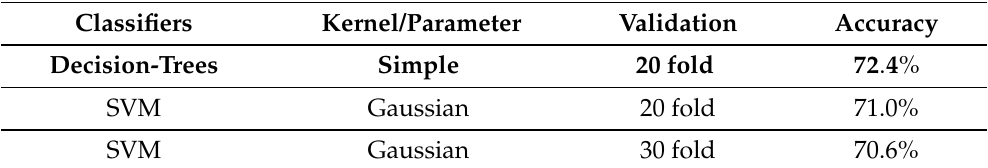
Table 9. The accuracy of classification of different classifiers of the diastolic-based sub-experiment (286 subjects).